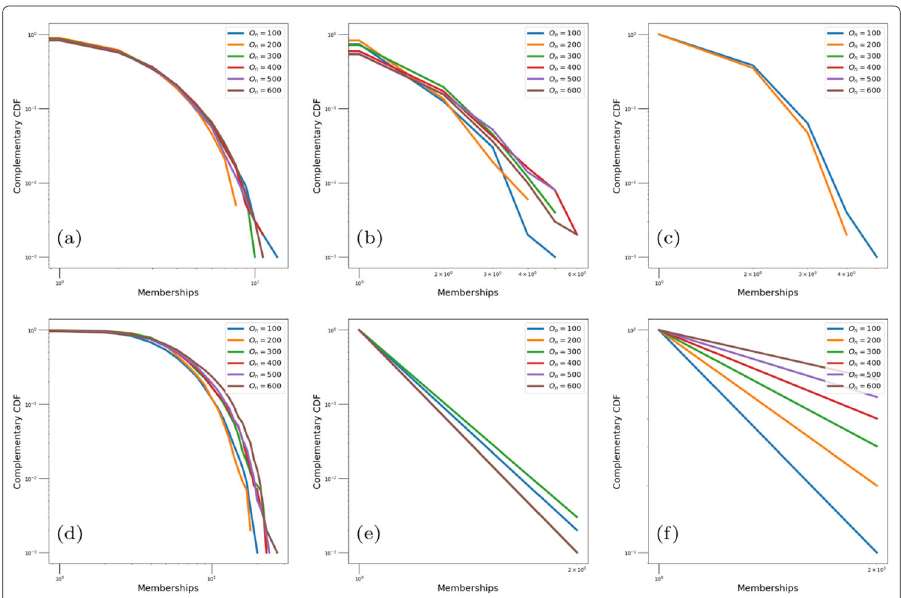
Fig. 15 Variation of the number of nodes in the overlapping region ( O n ) for LFR synthetic networks considering the membership of nodes: a Bigclam; b CFinder; c Copra; d Demon; e SLPA; f Ground-Truth